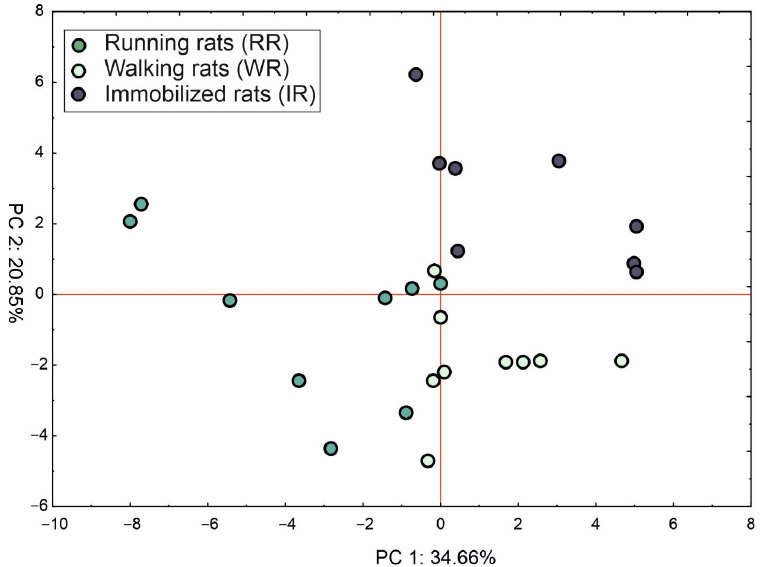
Figure 3. Principal component analysis of whole body parameters in the rats and the variables of both the right and left knee and the limb.